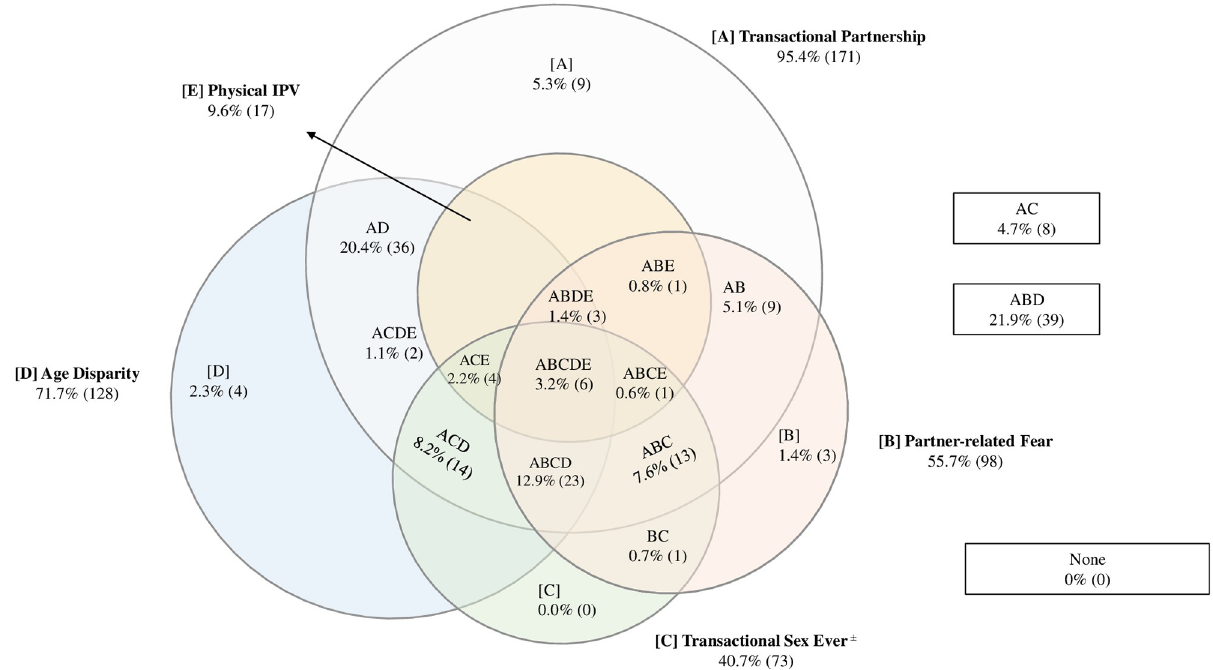
Fig 3. Venn diagram depicting gendered power imbalances at the interpersonal level in Lagos, weighted (n = 179) / . [A] Transactional partnership. [B] Partner-related fear. [C] Transactional sex (ever). [D] Age disparity. [E] Intimate partner violence (IPV). / cells are mutually exclusive; not proportionate to size; numbers fluctuate due to small amounts of missing data. ± Indicates lifetime measure, not specific to current